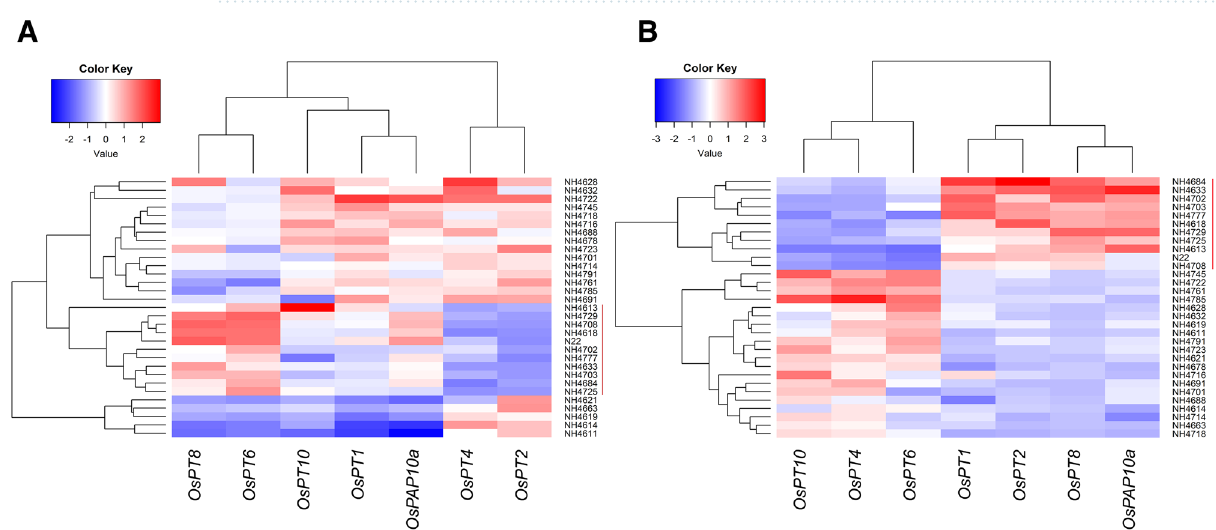
Figure 19. Heatmaps of relative expression levels of the genes involved in the P uptake and transport. Expression of these genes in seedlings obtained from germination of seeds harvested from low P plot was compared with the seedlings obtained from germination of seeds harvested from normal P plot. ( A ) Relative expression levels of genes in shoots of 12 days old seedlings. ( B ) Relative expression levels of genes in shoots of 24 days old seedlings. LGPS mutants and WT are shown by red